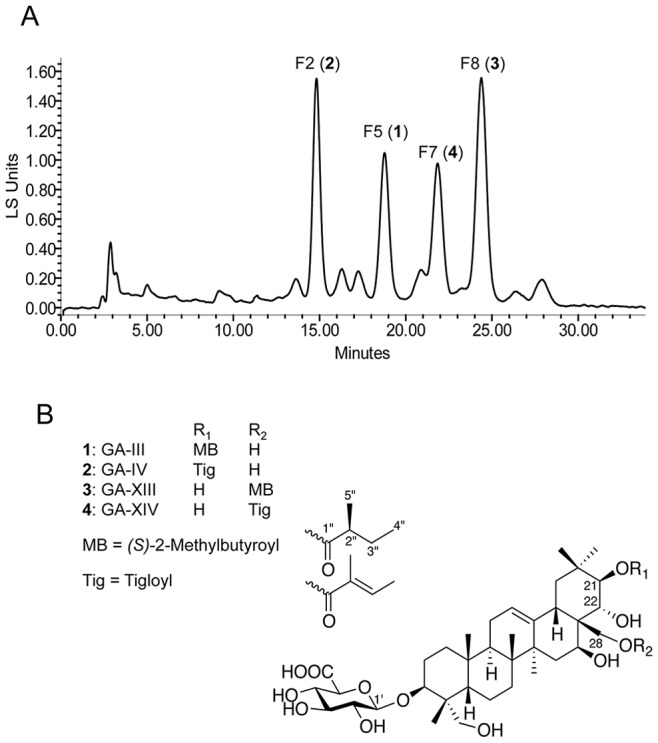
Purification and identification of gymnemic acids (GAs).(A) Solvent extracted and semi-purified GAs were fractionated on preparative HPLC (Sunfire C18 5 µm, 250×10 mm) using an isocratic mobile phase (see “Materials and Methods” for details). Fractions with major peaks were collected using an automated fraction collector, vacuum dried and assayed for inhibition of C. albicans yeast-to-hypha conversion. Individual fractions (F2, F5, F7 and F8) were evaluated for purity and molecular weight analyses using analytical HPLC-ELSD-DAD-MS, ESIMS, HRESIMS, 1H NMR and 13C NMR (see Figures S1–S20). (B) The four gymnemic acids (1–4) were identified using mass and NMR data (see Figures S1–S20 for details of GA species) according to Liu et. al. [35] and Yoshikawa et. al. [36], [37], [38]. The general structure of GA, methylbutyroyl and tigloyl are shown.